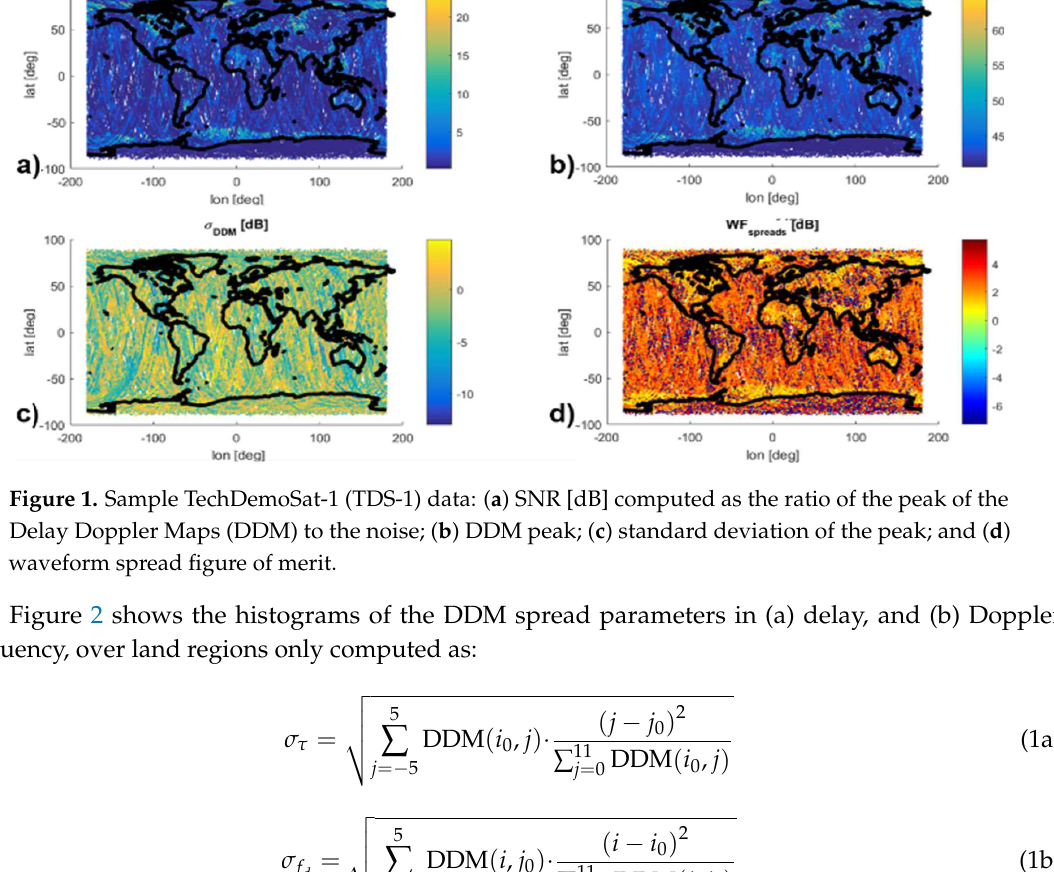
Figure 1. Sample TechDemoSat-1 (TDS-1) data: ( a ) SNR [dB] computed as the ratio of the peak of the Delay Doppler Maps (DDM) to the noise; ( b ) DDM peak; ( c ) standard deviation of the peak; and ( d ) waveform spread figure of merit.